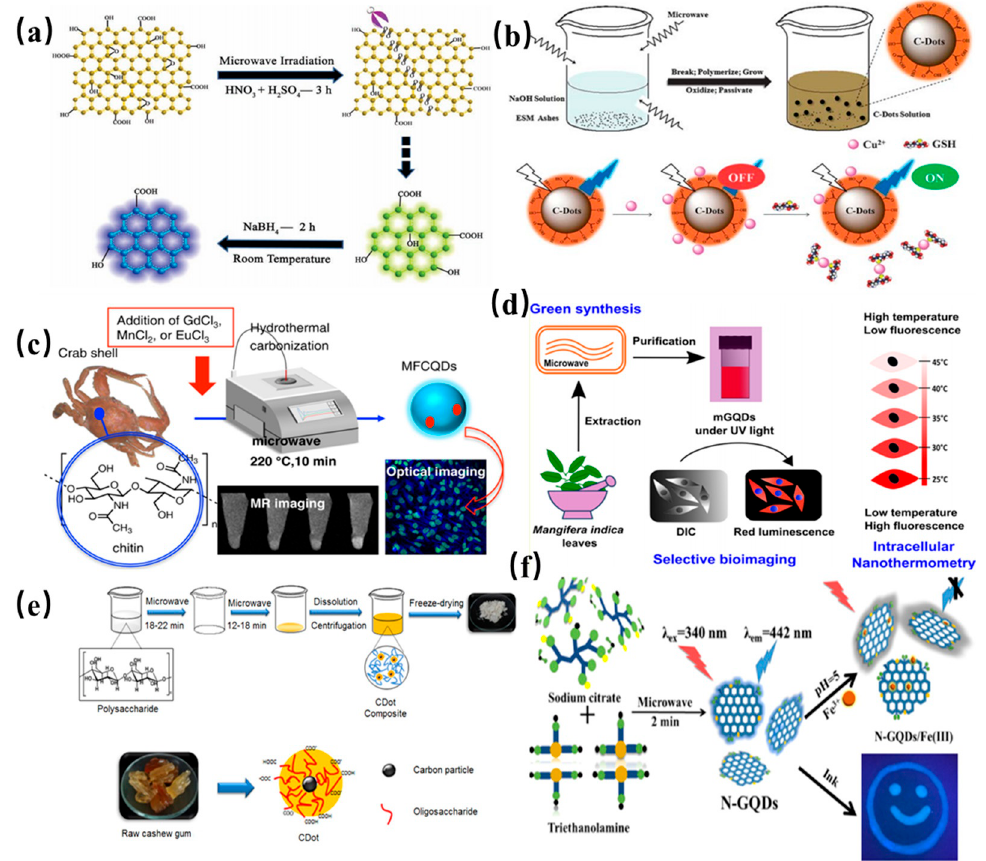
Figure 5. Schematic diagram of ( a ) Preparation route for gGQDs and bGQDs [60]. Copyright 2012, John Wiley and Sons. ( b ) Preparation process and application of the fluorescence CDs from protein- rich eggshell membranes by microwave-assisted approaches [61]. Copyright 2012, Royal Society of Chemistry. ( c ) Synthesis of the CDs from crab shell [62]. Copyright 2017, American Chemical Society. ( d ) Preparation and application of the soluble CDs from mango leaves [63]. Copyright 2017, American Chemical Society. ( e ) Preparation of the fluorescent CDs composites from raw cashew gum [64]. Copyright 2015, Sociedade Brasileira de Qu í mica. ( f ) Synthesis of fluorescent N-GQDs from triethanolamine and sodium citrate [65]. Copyright 2019, American Chemical